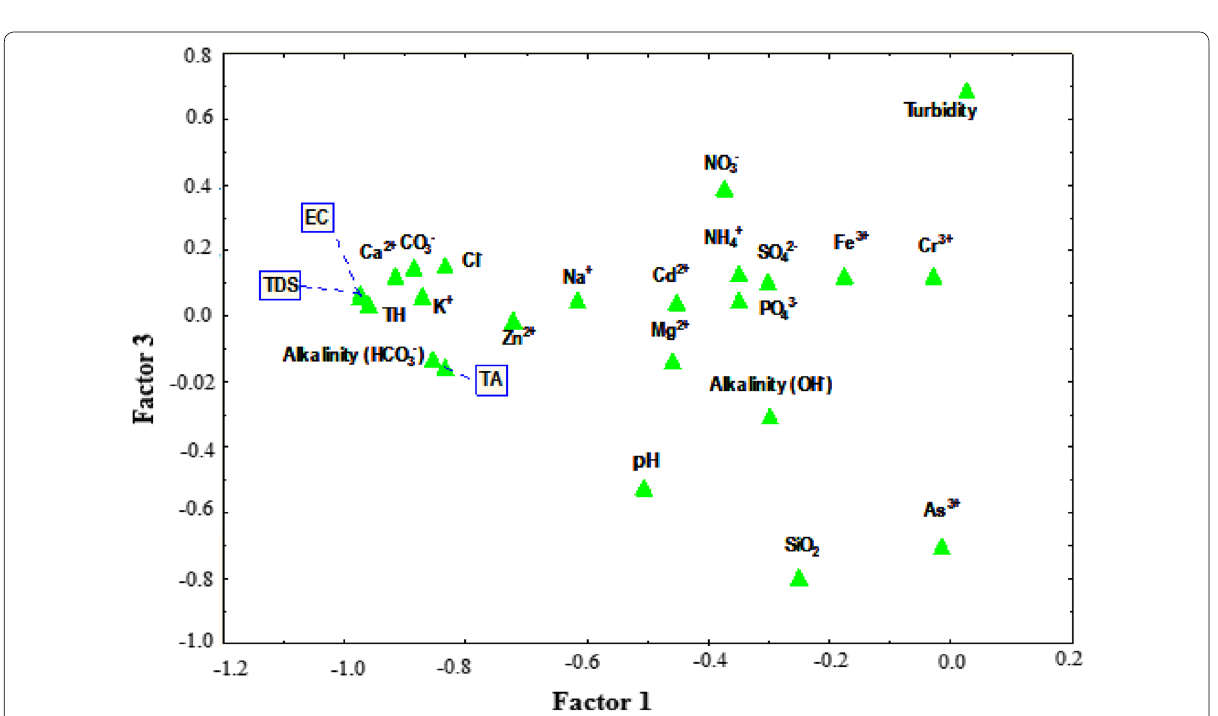
Fig. 9 Factor analysis diagram. Factor loadings: Factor 1 versus Factor 3. Loading: unrotated, extraction: principal